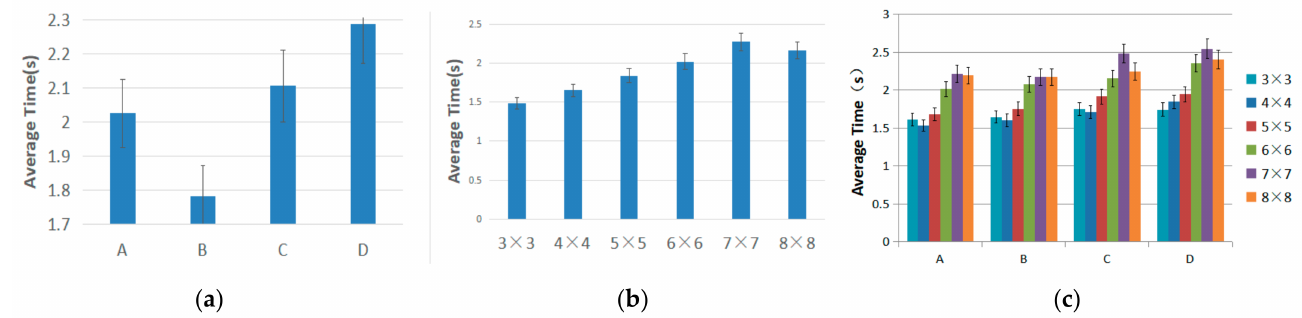
Figure 7. The average time of comparative Experiment 1. The error bars represent a 95% confidence interval: ( a ) average selection time with different regions; ( b ) average selection time with different target size levels; and ( c ) average selection time for different target size levels and different regions (A, B, C, and